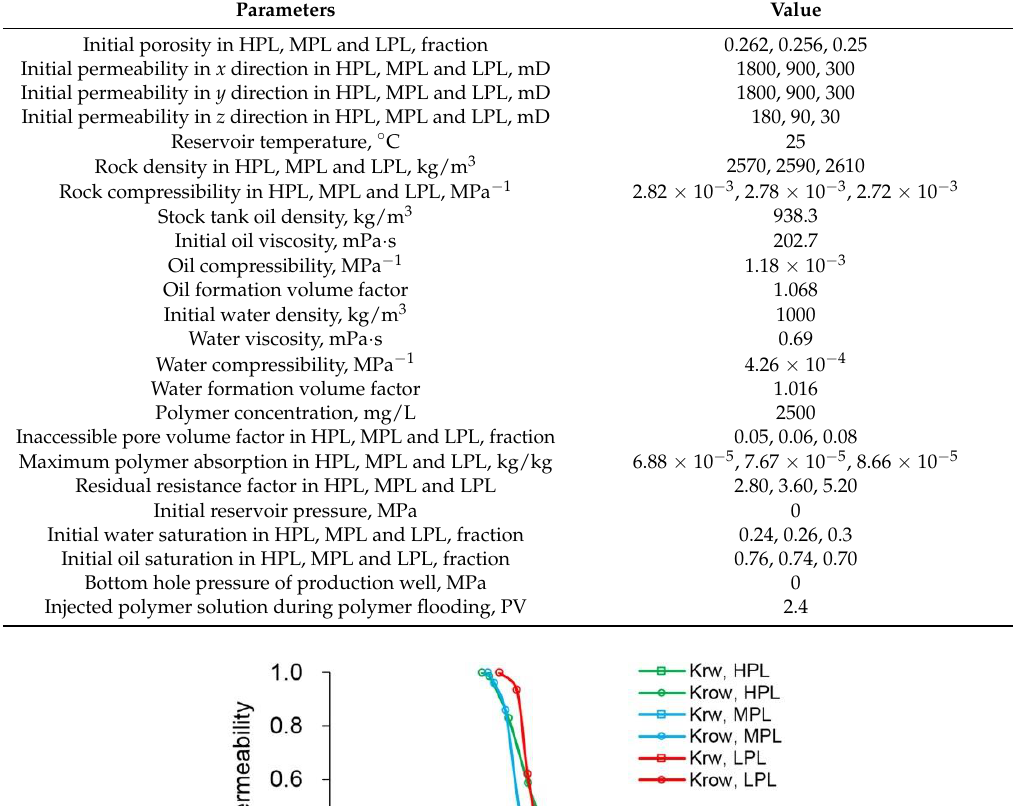
Table 7. The reservoir property, fluid property, initial conditions and production data of Case 1. Parameters